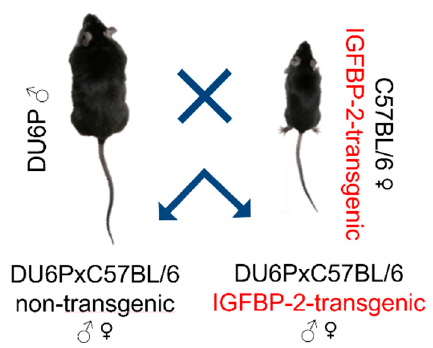
Figure 1. Breeding scheme: male mice selected for high protein mass (DU6P) were crossed with female hemizygous insulin-like growth factor binding protein 2 (IGFBP-2) transgenic mice (C57BL/6). Accordingly, the autosomal genetic background in the o ff spring was equally contributed by non-inbred DU6P mice and inbred C57BL / 6 mice. Due to hemizygosity, the litters were composed of IGFBP-2 transgenic mice and non-transgenic controls.